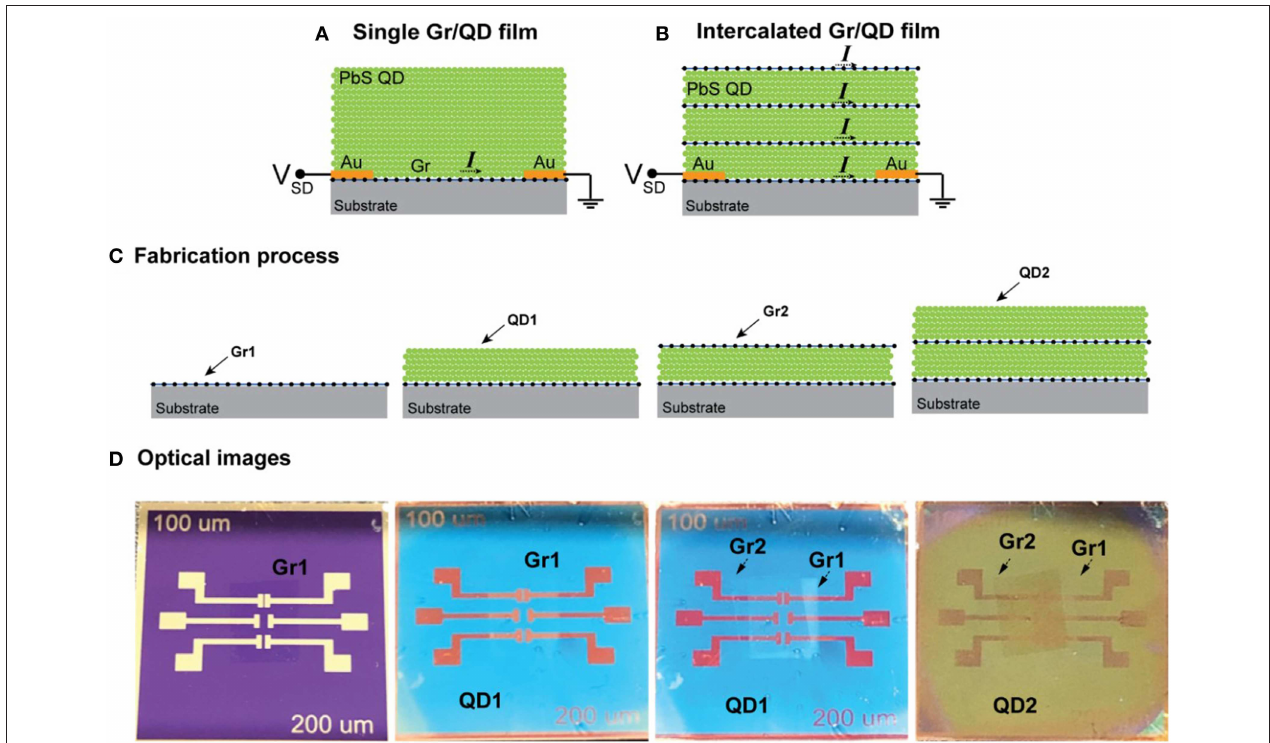
FIGURE 1 | Intercalated devices. (A) Conventional hybrid Gr/QD dot device with single graphene layer at the bottom. (B) Intercalated graphene layers in an intercalated Gr/QDs configuration enhancing charge collection and transport. (C) Schematic of the sequential deposition of Gr and QD layers to realize intercalated devices. (D) Optical images of an intercalated device at each step during fabrication